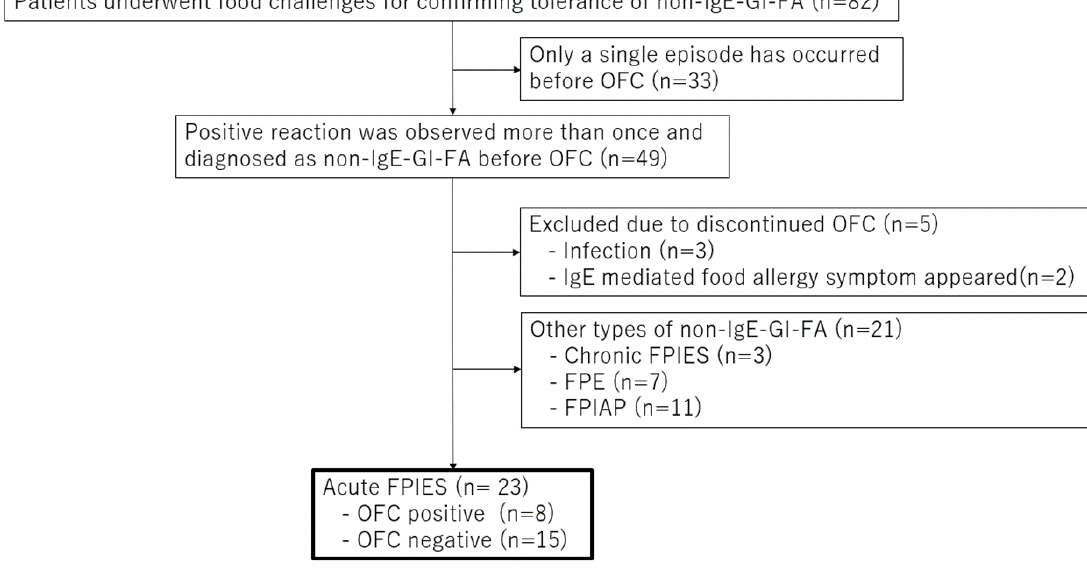
Figure 1. Flow diagram of the subject selection process. Non-IgE-GI-FA, non-IgE-mediated gastro- intestinal food allergy; OFC, oral food challenge test; FPIES, food protein-induced enterocolitis syndrome; FPE, food protein-induced enteropathy; FPIAP, food protein-induced allergic proctocolitis.